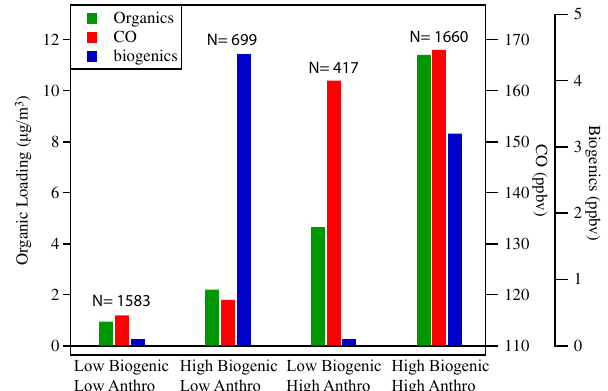
Fig. 12. Median OA loading for data that has been binned according to anthropogenic (CO) and biogenic (isoprene+MVK+MACR) tracer concentrations. Tracer concentrations are categorized as “low” if they fall in the lower quartile of all data and “high” if they fall in the upper quartile. Median CO and biogenic tracer concen- trations for each bin are also shown. The number of points in each bin is indicated above the